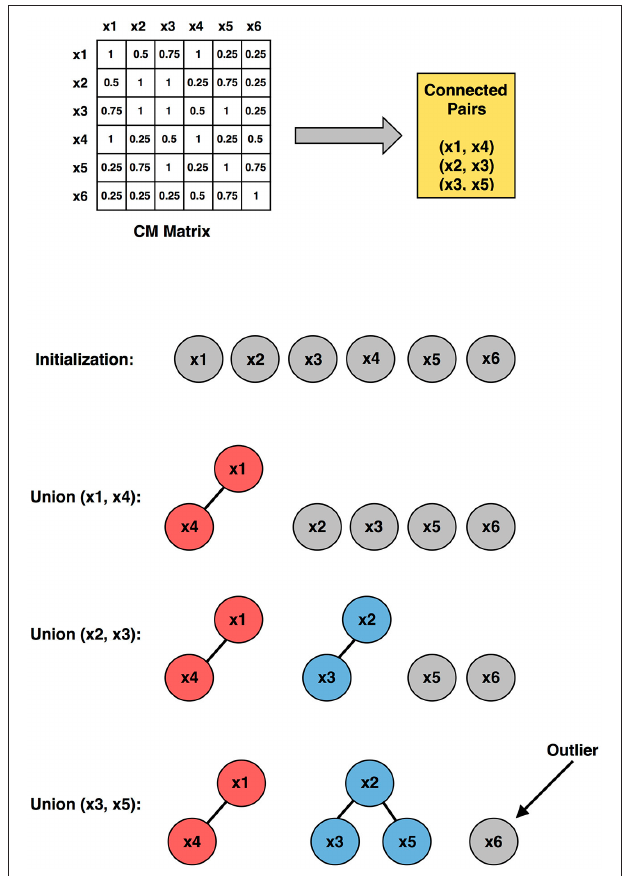
FIGURE 2 | Illustration of the outlier subject elimination process (using upper triangular connected pairs), employing the co-association matrix approach. x 1 , x 2 , ··· , x 6 are six representative subjects used in the